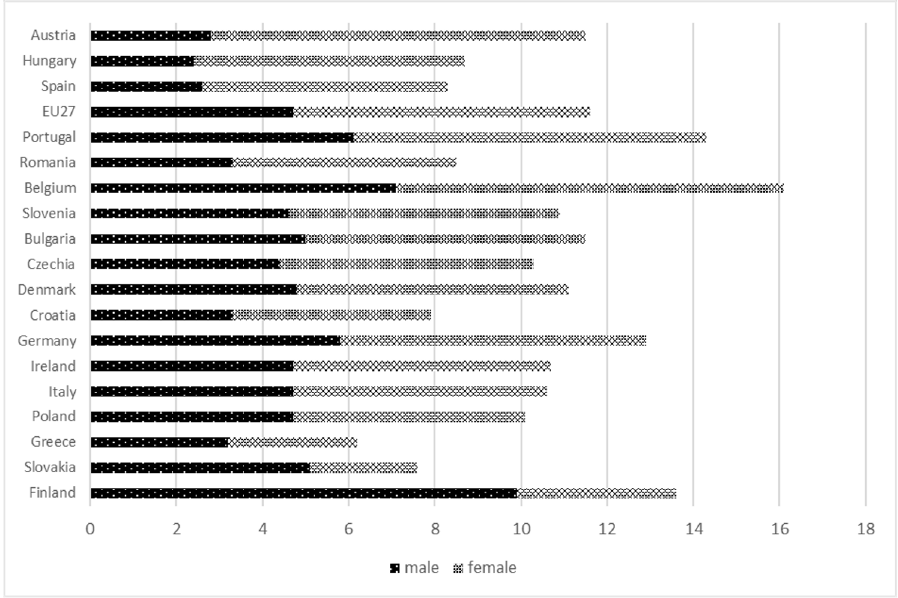
Figure 6. Men and women prevented from due time work because of family respon-